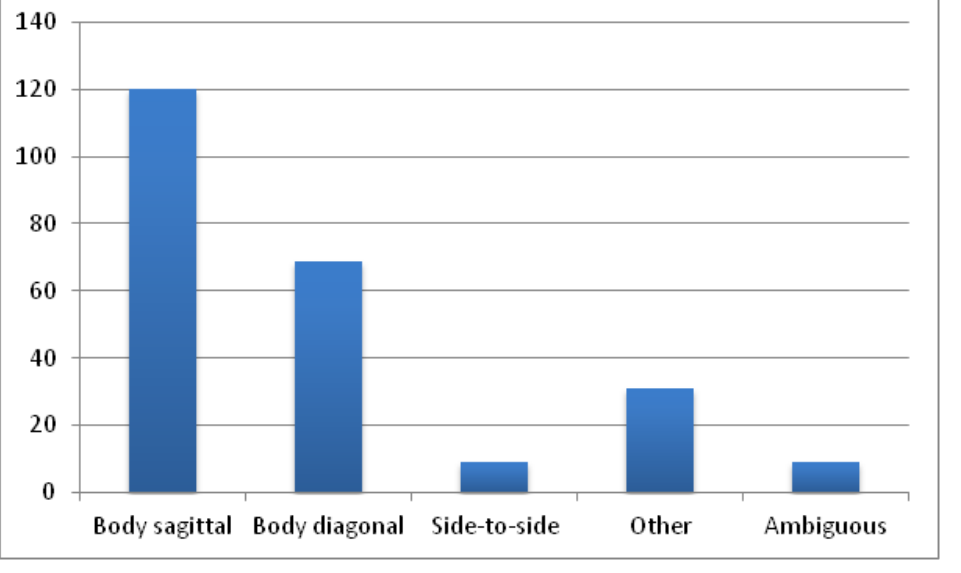
Figure 11. Direction of movement in clauses involving a third to third person referent (number of tokens) Figure 11 indicates that, for clauses involving third to third person arguments, signers most frequently use movement to and from the body on the sagittal axis (n = 120, 50%). The second most frequent category is movement to and from the body diagonally (n = 69, 29%). When ‘body-sagittal’ and ‘body-diagonal’ are combined, this results in a total of 189 tokens (79%) which are articulated to or from the body (either sagittally or diagonally). Movement between two locations in space (side-to-side) is least likely to be used